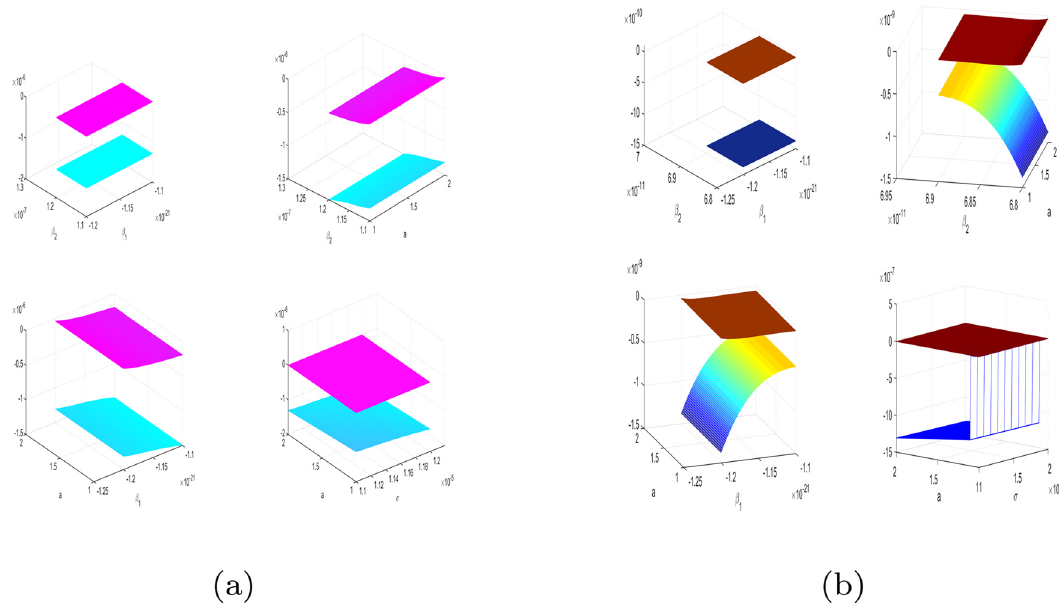
Figure 5: ( a ) The regions of parameters in Proposition 3.2 and ( b ) the regions of parameters in Theorem